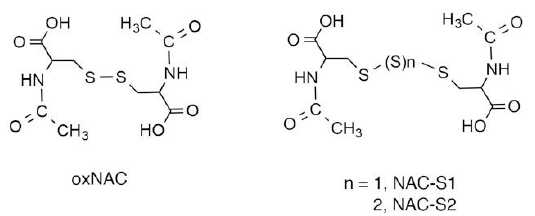
Figure 5. Chemical structures of NAC polysulfides. oxNAC is a control reagent without polysulfide- donating capability.